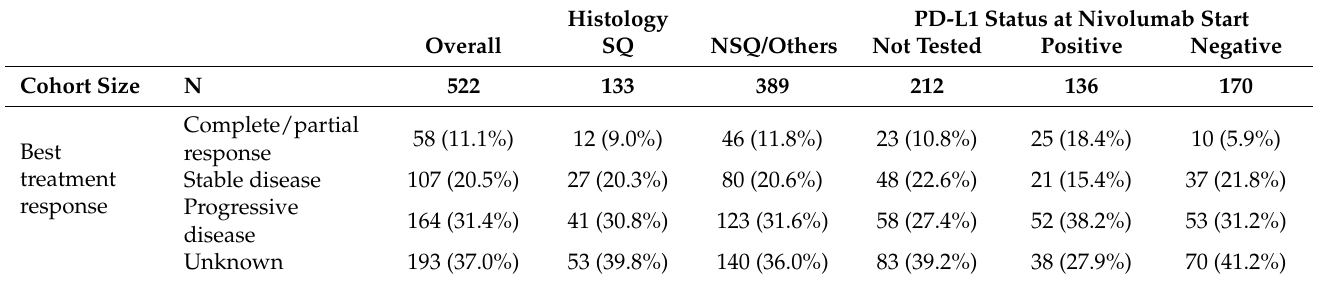
Table 2. Best treatment response to nivolumab in patients treated with nivolumab in 2L+ or beyond in CRISP overall, by histology and by PD-L1